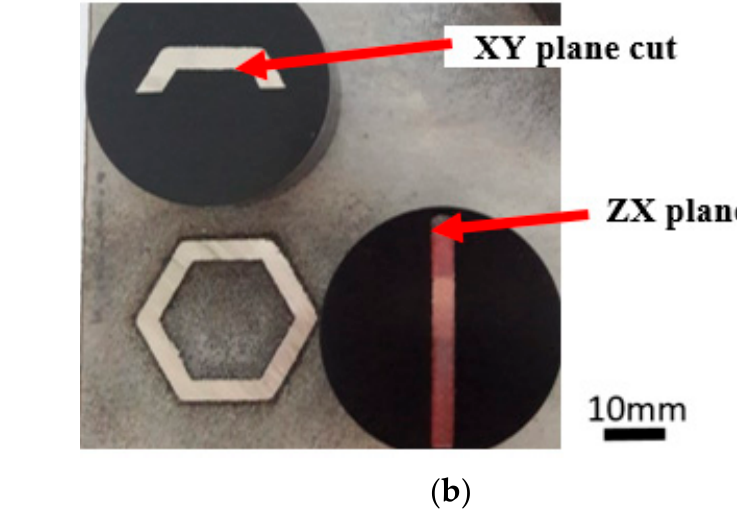
Figure 4. ( a ) The scanning strategy of the DED-processed honeycomb structures—four scans over the